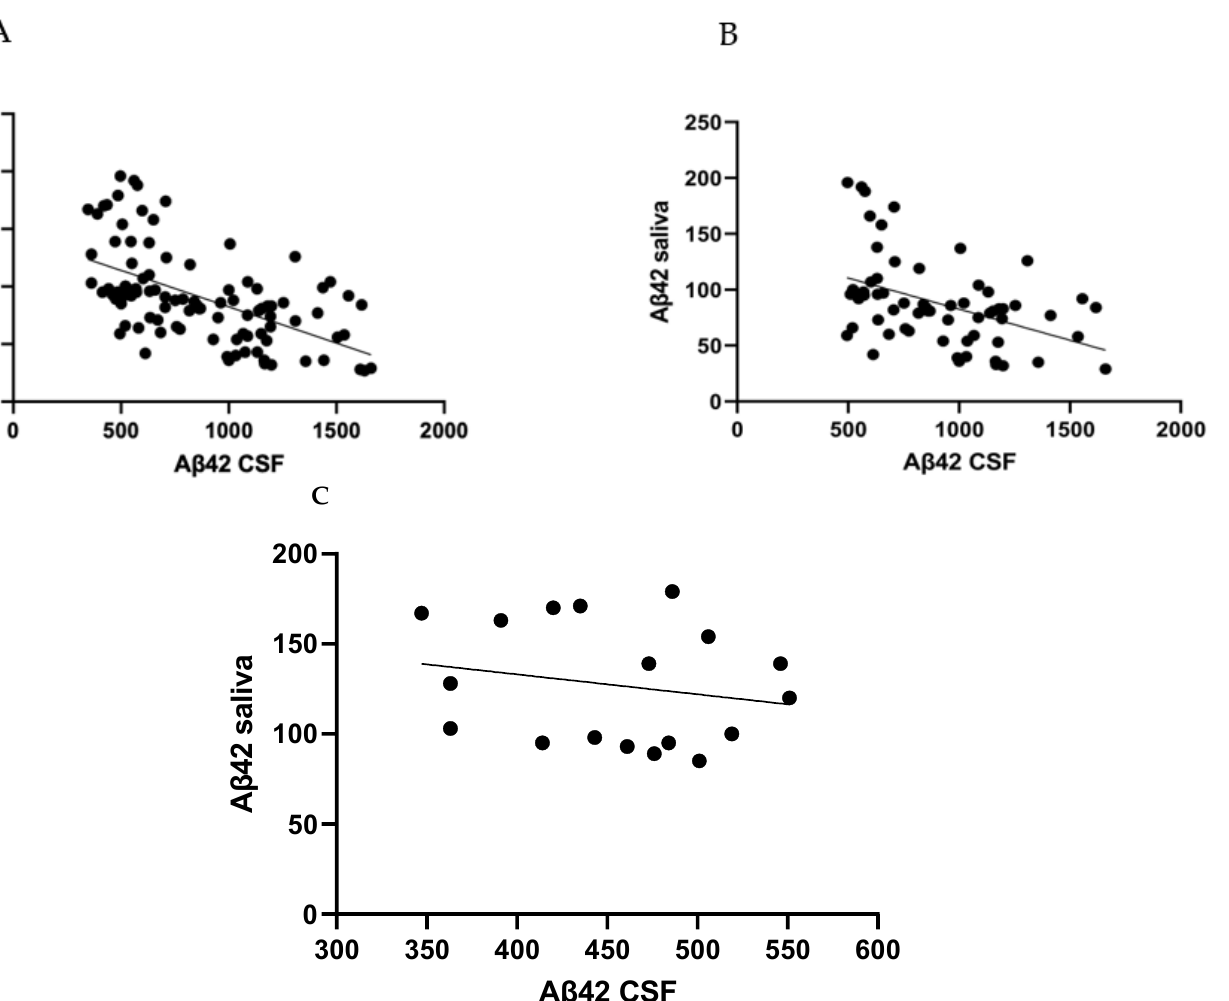
Figure 4. Correlation between salivary A β 42 concentrations and CSF A β 42 concentrations ( A ) in the overall population (r = − 0.562, p < 0.001); ( B ) in the non-AD group (r = − 0.443, p < 0.001); and ( C ) in the AD group (r = − 0.205, p = 0.415).